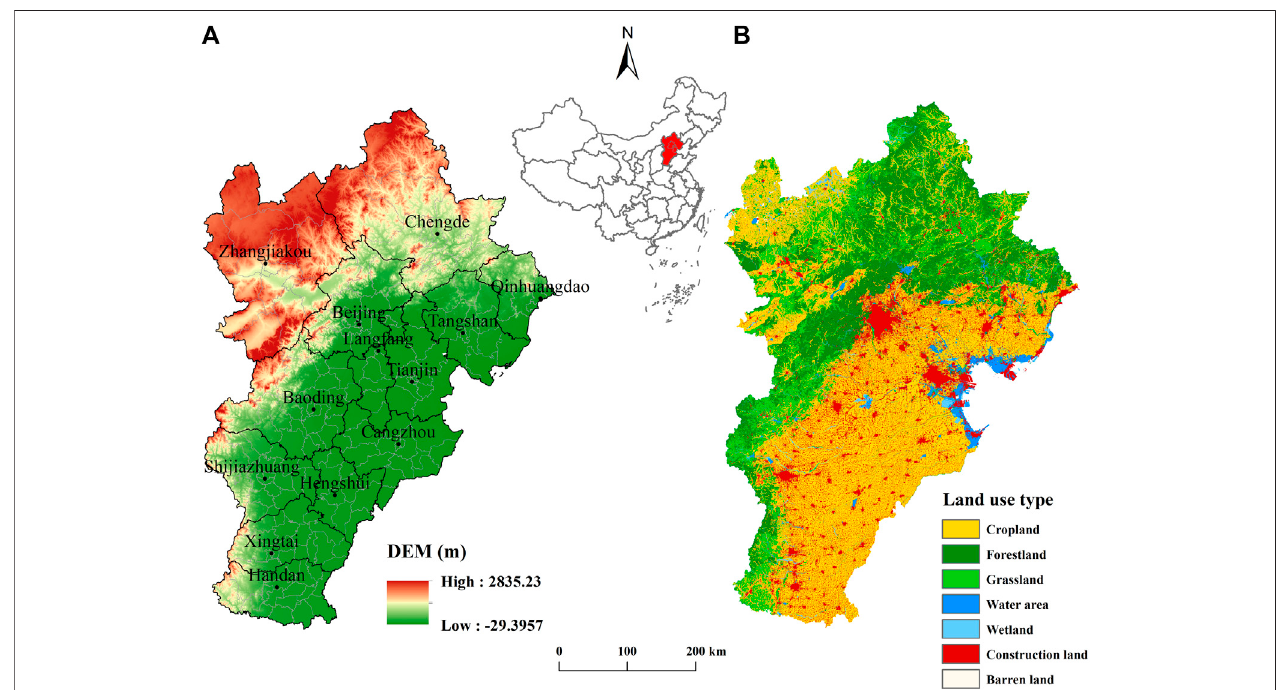
FIGURE 1 | Location of the Beijing-Tianjin-Hebei region. (A) Administrative boundary and elevation. (B) Land use type in 2020.